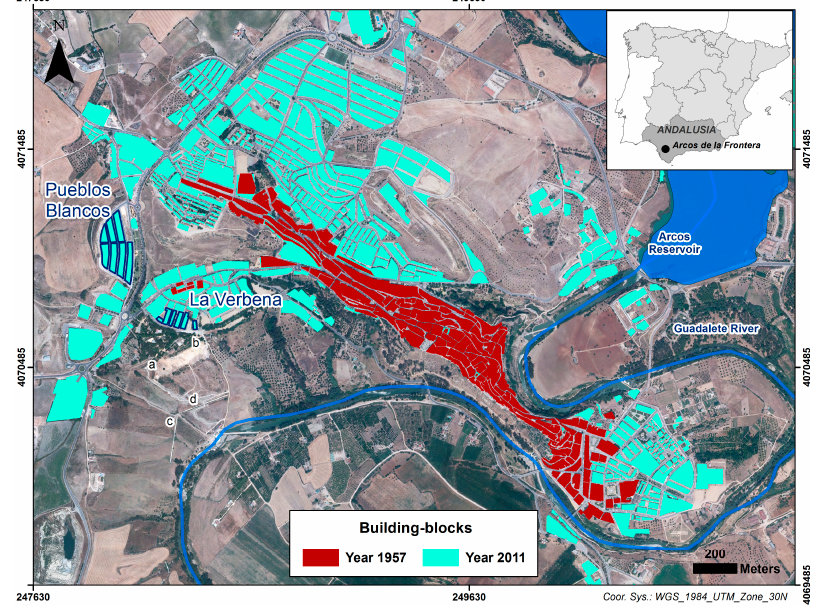
Figure 1. Arcos de la Frontera location. Urban expansion from the ‘50s to the present can be appreciated through the depicted blocks of buildings. The La Verbena and Pueblos Blancos buildings are depicted in dark blue.